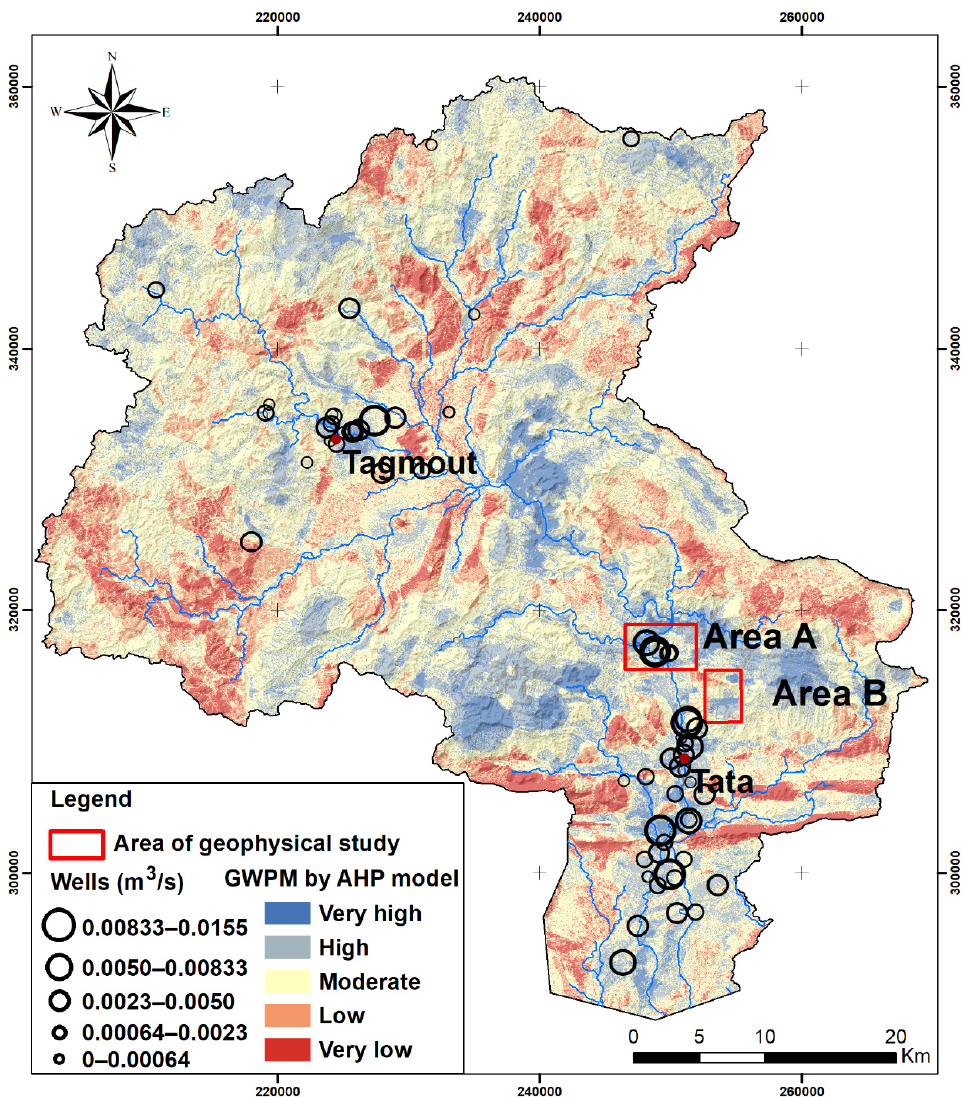
Figure 7. Groundwater potential map of the Tata basin.